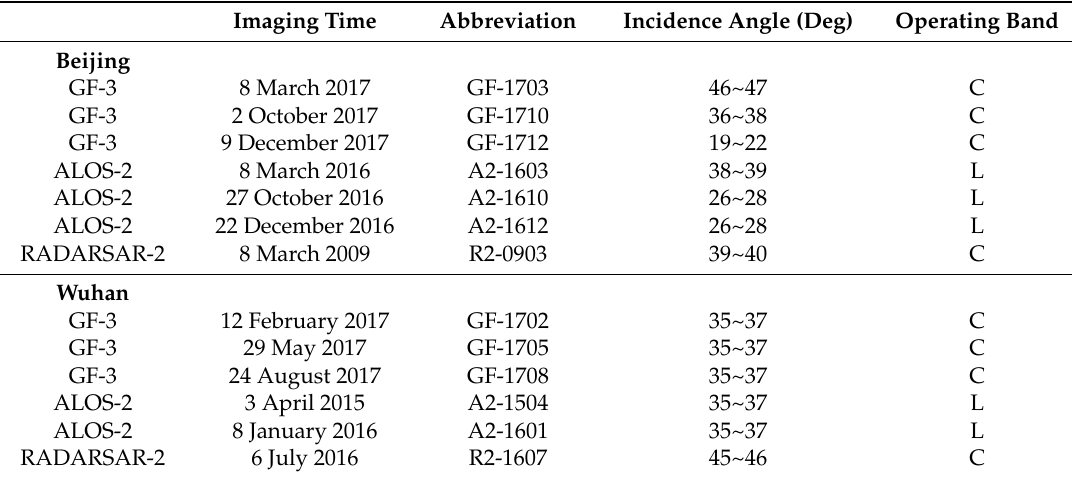
Table 1. Specifications of the PolSAR images